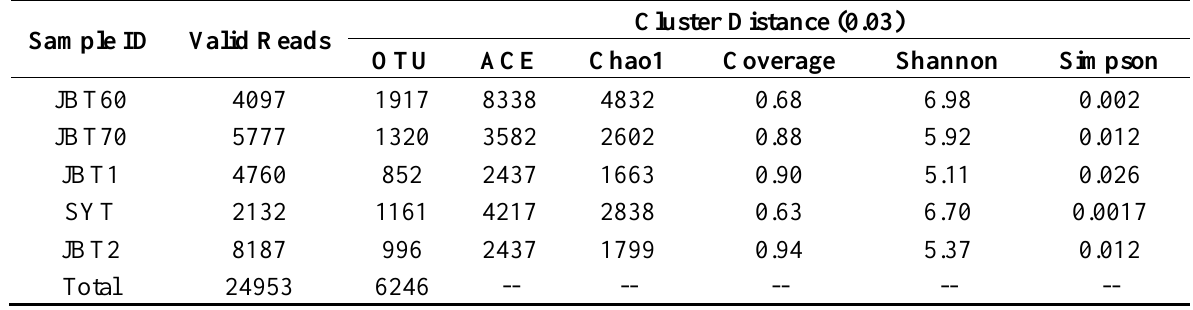
Table 2. Similarity-based OTUs and species richness estimates of the bacterial phylotypes in the five samples. The abbreviation of samples is shown in Table